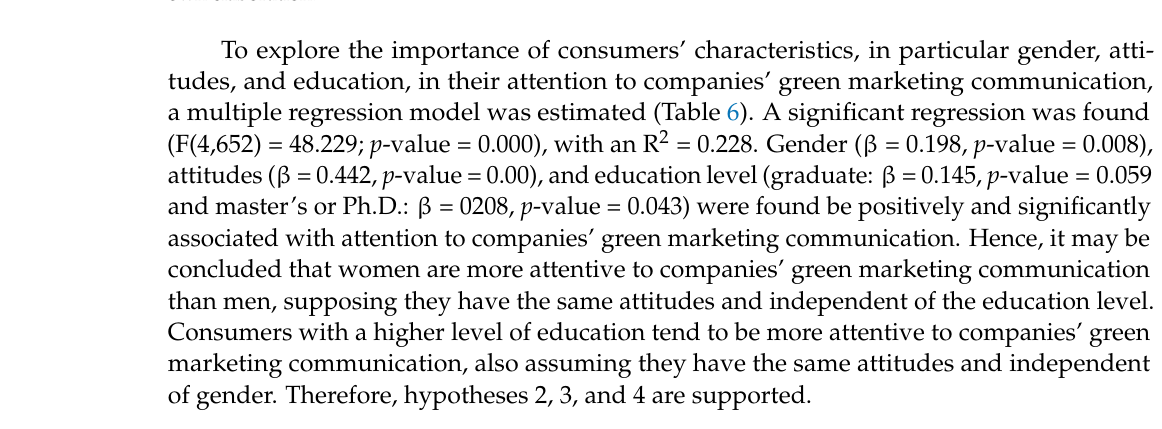
Table 6. Multiple regression